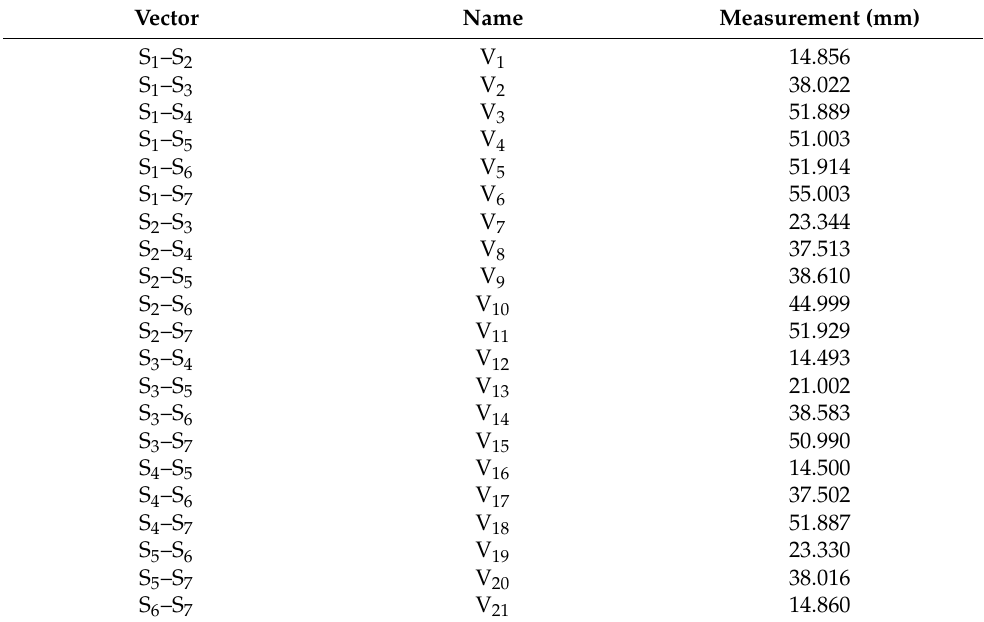
Figure 1. STL image of the reference model. ( a ) Labelled spheres where S 1 , S 2, S 6 and S 7 represent the posterior region of the model while S 3 –S 5 represent the anterior region. Attachment vents are present between S 2 –S 3 and S 5 –S 6 . ( b ) Red markings indicating the location for the coordinate measuring machine measurements. ( c ) Dotted red line indicating the equator of the spheres. Table 2. Definition of the 21 vectors extending between the hypothetical spheres centre and the corresponding reference measurements based on the reference